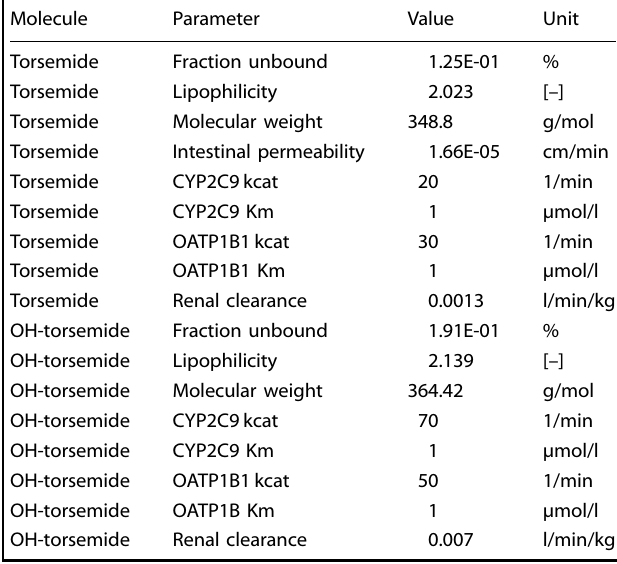
Table 4. Parameterization of the torsemide mean value